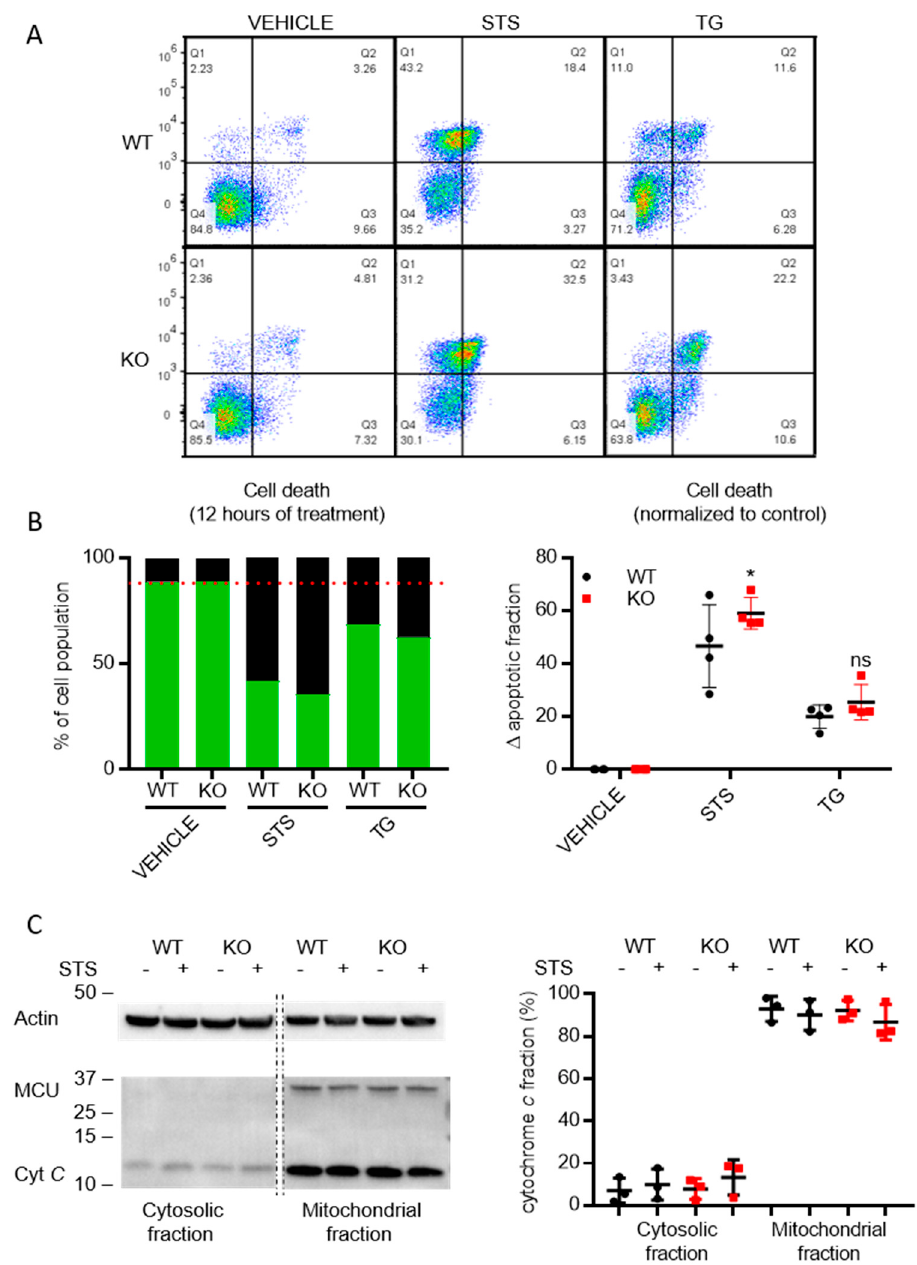
Figure 6. TMBIM5-KO cells are more sensitive to staurosporine than WT cells. ( A ) Representative dot plots from flow cytometry analysis detecting apoptosis in Annexin V-FITC / 7-AAD-stained cells. ( B ) Cells death was assessed via flow cytometry after 12 h of treatment with vehicle, staurosporine (STS), or thapsigargin (TG). The ∆ apoptotic fraction was calculated by subtracting the cell death occurring in the vehicle-treated condition. TMBIM5-KO cells were more sensitive to staurosporine treatment than WT cells. Graphs showing mean ± SD. * p < 0.05 analyzed with one-way ANOVA. ( C ) Immunoblot analysis (left) and quantification (right) of cytochrome c release after 8 h of treatment with staurosporine (STS). MCU was used as a marker for proper mitochondrial fractionation. Graphs showing mean ± SD.